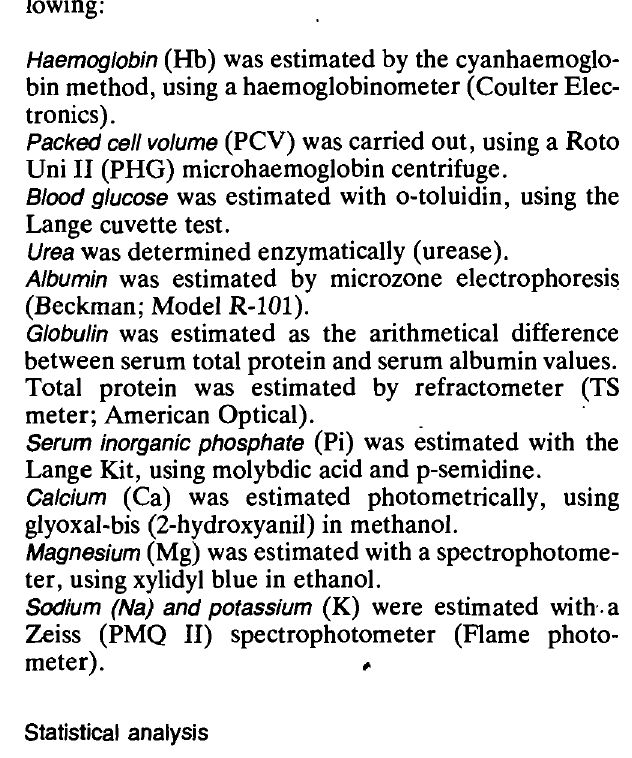
Table 1: THE CHEMICAL COMPOSITION OF THE MILK SUBSTITUTE AND MILK SUBSTITUTE-WHEY DIETS (VALUES EXPRESSED ON AN AS-FED BASIS)